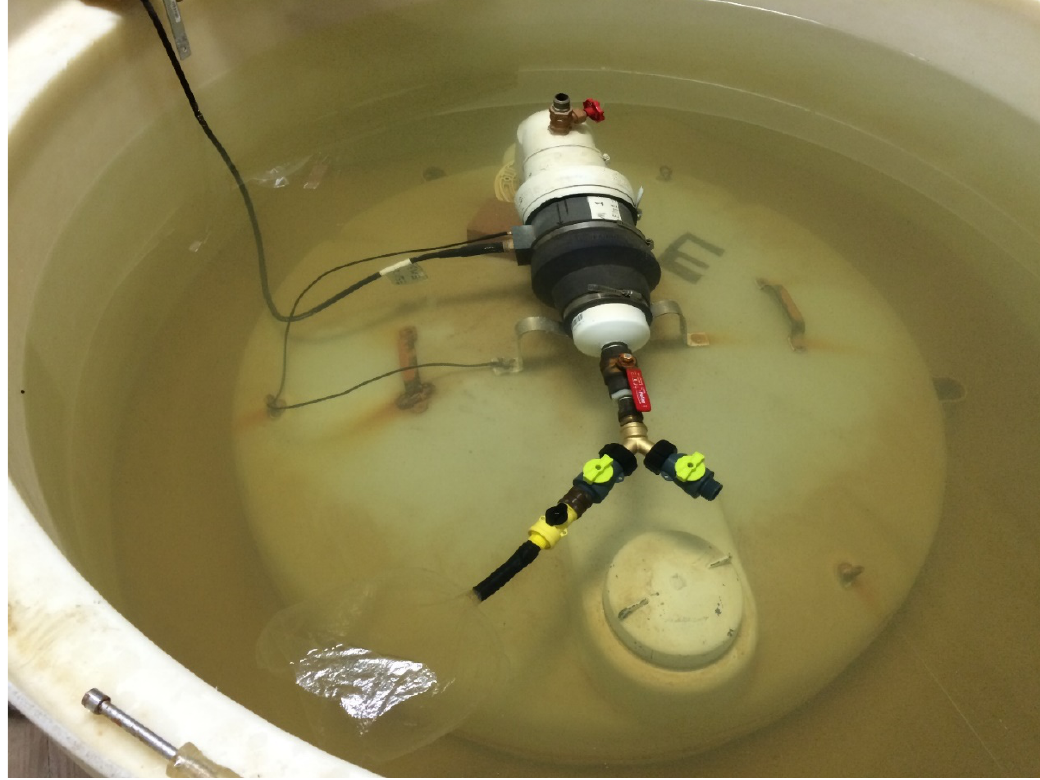
Figure 2. Electromagnetic seepage meter (ESM) installed in a 1.5 m diameter seepage calibration